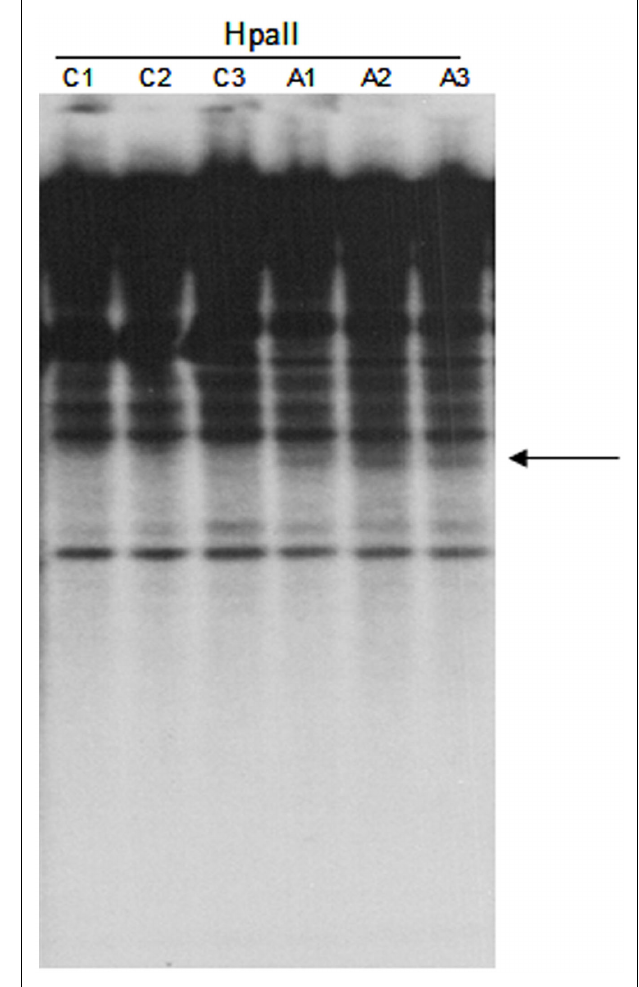
FIGUREA2 | DNA gel blot of untreated and 5-aza-2-deoxycytidine treated Hi-IIA × B suspension cultures hybridized with the TCUP internal probe. Hpa II digested genomic DNA of three independent untreated cultures (C1–C3) and three independent 5-aza-2-deoxycytidine treated cultures (A1–A3). An arrow marks the location of novel bands present in the Hpa II digested